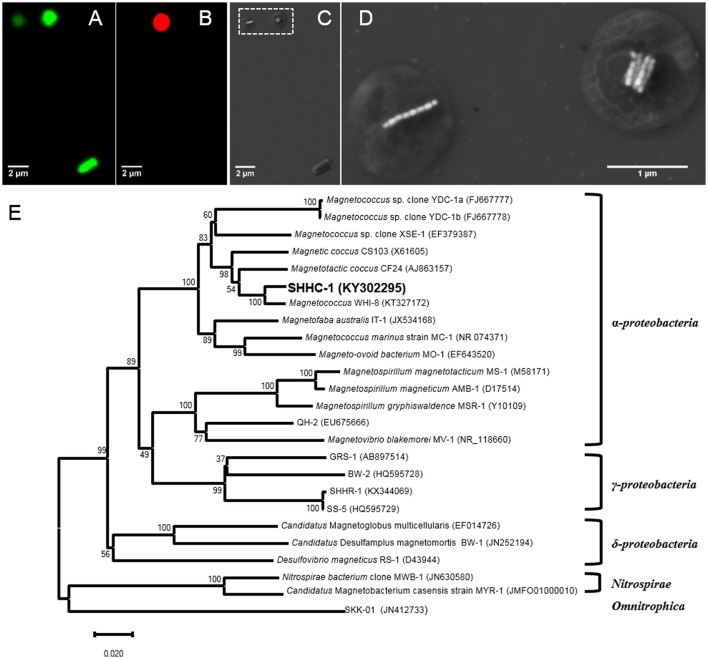
(A–D) Phylogenetic and structural identification of SHHC-1 cells by coupled FISH-SEM. (A) Fluorescence microscopy image of SHHC-1 cells in situ hybridized with the 5′-FAM-labeled universal bacterial probe EUB338. (B) Fluorescence microscopy image of SHHC-1 cells hybridized in situ with the 5′-Cy3-labeled SHHC-1-specific probe SHHC1228. (C) Low-magnification SEM image of the same field of view as in (A). (D) High-magnification SEM images of two magnetococci cells outlined in image (C) by a white dashed square (E) Phylogenetic tree, based on 16S rRNA gene sequences, showing the position of strain SHHC-1 in the Chromatiales order of the Alphaproteobacteria class. Bootstrap values (higher than 50) at nodes are percentages of 1,000 replicates. Bar represents 2% sequence divergence.